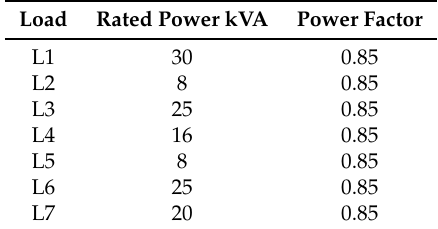
Table A2. Characteristics of the loads.